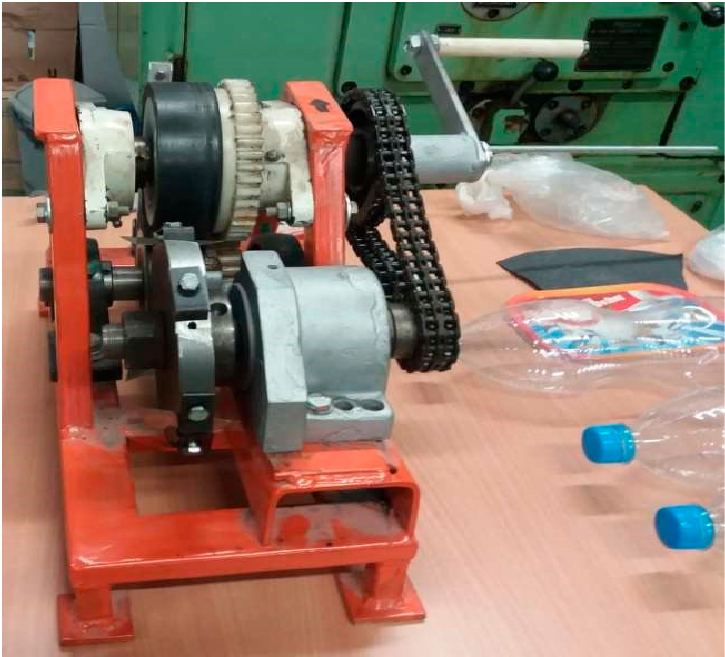
Figure 5. Device for obtaining PET fibres from used beverage bottles.